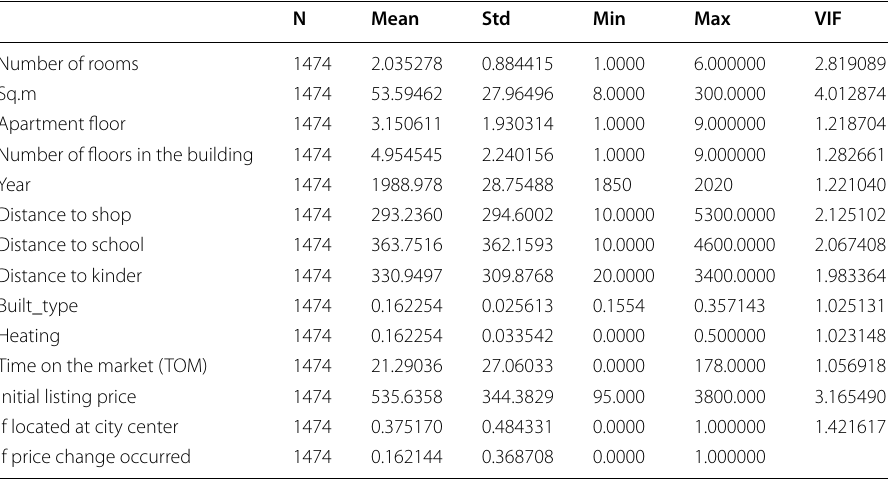
Table 2 Sample descriptive statistics for month July rent